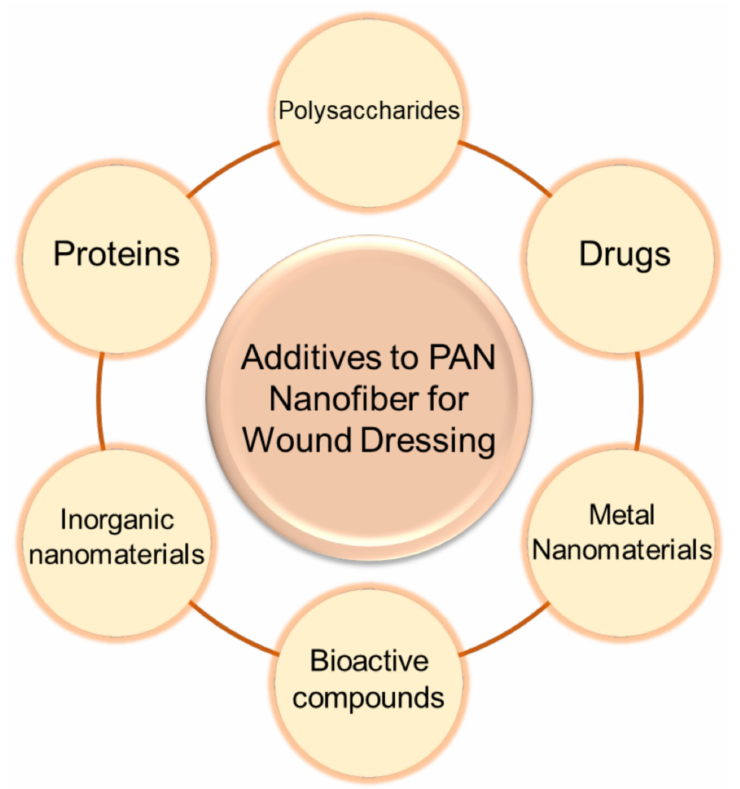
Figure 8. Various additives used in PAN nanofibers to enhance their biological and physicochemical properties as wound